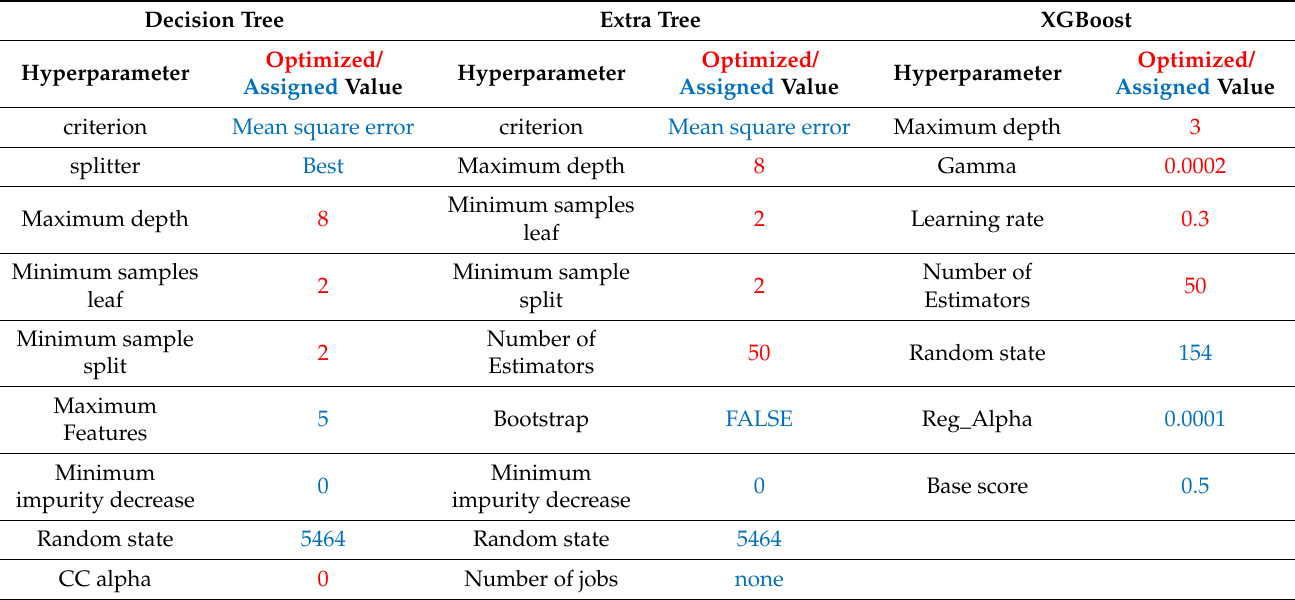
Figure A1. Hyperparameter tuning of tree-based models. Table A1. Optimized/default hyperparameters of tree-based